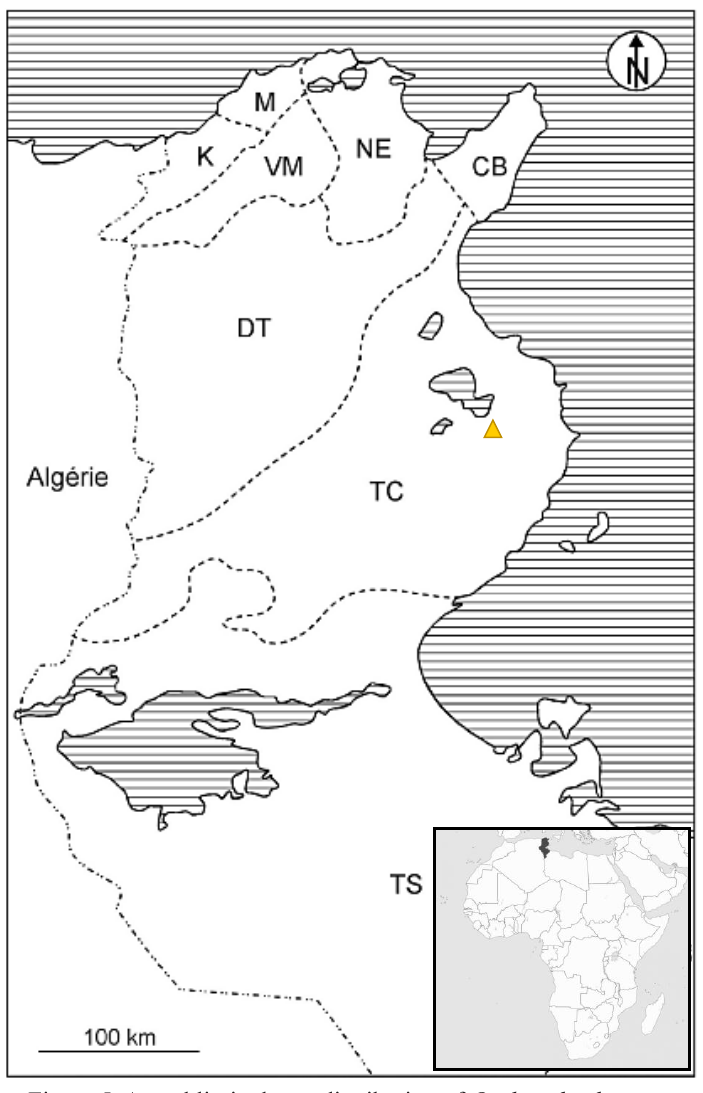
Figure 5. Actual limited area distribution of Orobanche dominae (brownish-yellow triangle) within central Tunisia